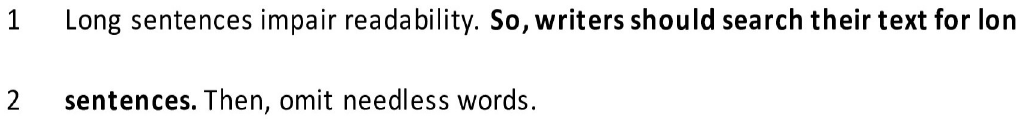
Fig 1. Conceptual visualization of standard text. Participants judged whether the target sentence (bolded) on each trial contained more or fewer than 17 words.